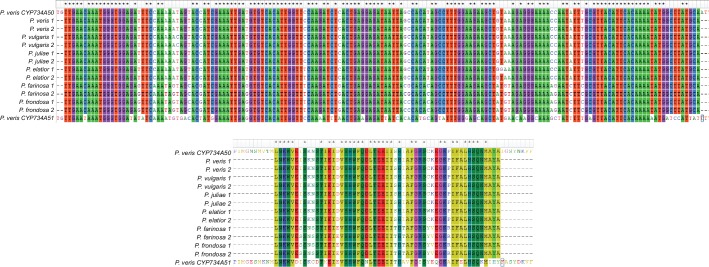
Specificity of PCR-genotyping in different Primula species.Multiple-sequence alignments at the DNA (top) or protein (bottom) levels of the CYP734A50-specific fragments (see Figure 2E,F) amplified from the indicated species. PCR-products from two S-morph individuals were sequenced from each species. The corresponding region of CYP734A51 is included for comparison to show specificity of amplification of the CYP734A50 orthologues.